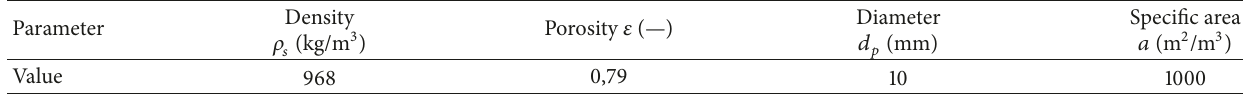
Figure 2: Experimental setup of laboratory pilot scale; A: feeding tank; B: dosing pump; C: oximeter; D: sampling; E: fixed bed; F: porous diffuser; G: discharge valve; H: recirculation pump; I: membrane; J: outlet valve; K: liquid flowmeter; L: valve water; M: compressor; N: gas flowmeter. Table 1: Physical packing characteristics (AnoxKaldnes